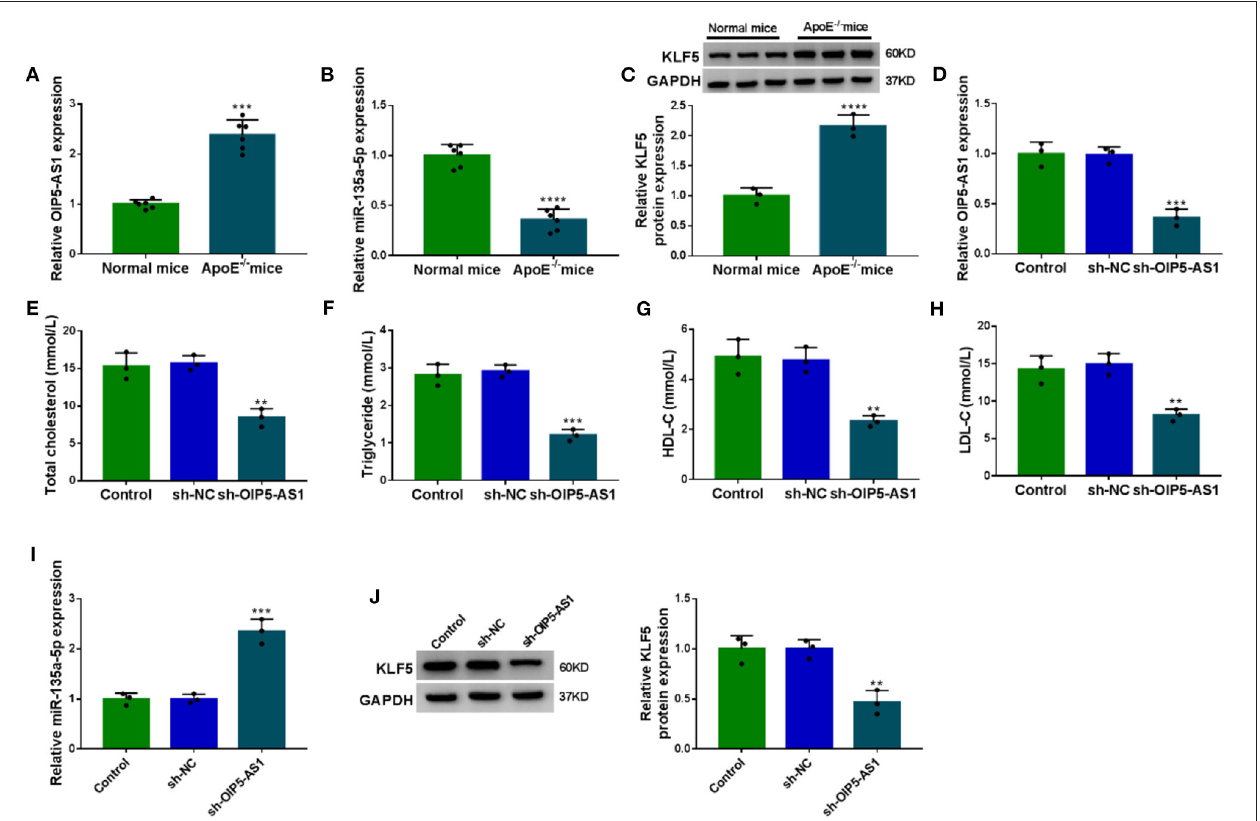
FIGURE 8 | The silencing of OIP5-AS1 weakened atherosclerosis progression in ApoE − / − mice. ApoE − / − mice were fed with a high-fat diet and wild-type C57BL/6J mice (normal mice) were fed with normal chow. In the 6th week, the ApoE − / − mice were injected with PBS (control), sh-NC, or sh-OIP5-AS1 by caudal vein every week until the 12th week ( n = 6 per group). At the end of the experiments, serum samples were harvested from all mice. (A–D) OIP5-AS1, miR-135a-5p, and KLF5 expression levels determined by qRT-PCR and western blot in the serum samples. (E–H) The levels of total cholesterol, triglyceride, HDL-C, and LDL-C in the serum samples from ApoE − / − mice. (I,J) The levels of miR-135a-5p and KLF5 by qRT-PCR and western blot in the serum samples. n = 6 independent biological replicates; error bars represented SD; ** P < 0.01, *** P < 0.001, or **** P < 0.0001 by Student’s t -test or one-way ANOVA with Tukey’s post hoc test.